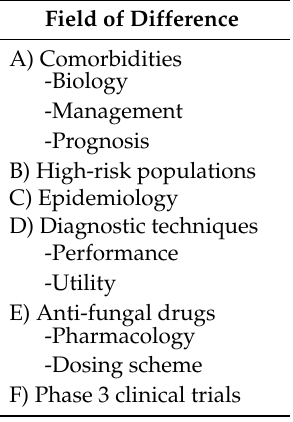
Table 1. Differences between pediatric and adult Invasive